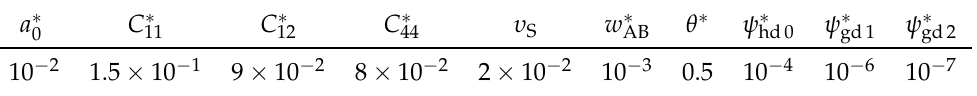
Table 1. Typical non-dimensional parameter values adopted in the simulations.